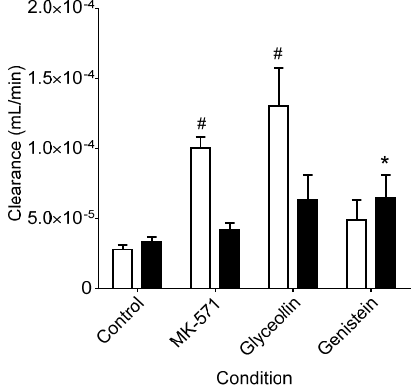
Figure 2. CDF clearance in Caco-2 cells. Clearance values are based on the same experiments summarized in Figure 1, with normalization of permeability by cell concentrations measured at the conclusion of each 120-min incubation. Open bars represent transport in the AB direction and closed bars in the BA direction. * and # indicate significantly different from the corresponding control/transport direction, p < 0.05 and p < 0.01, respectively, according to one-way ANOVA followed by Tukey’s t -test for multiple comparisons. For MK-571 and glyceollin, AB directional clearance was greater than BA directional clearance ( p < 0.05); there was no such difference for controls and genistein.